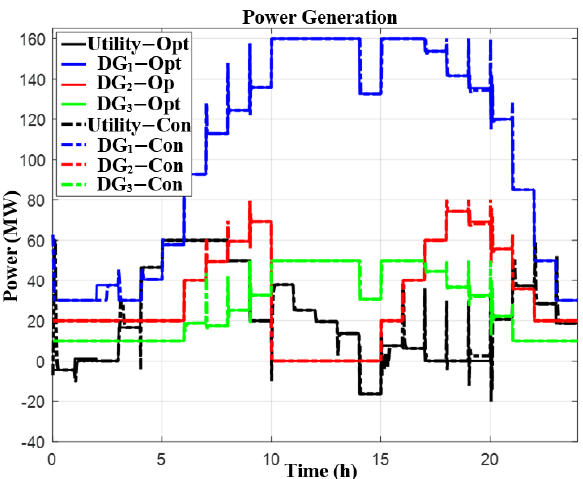
Figure 16. Output powers while generation unit 2 is under DoS/DDoS attack.